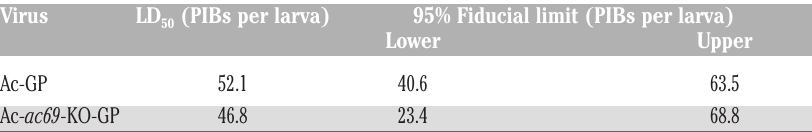
Table 2. Dose mortality of Ac-GP and Ac- ac69 -KO-GP for third-instar T.ni larvae . Virus